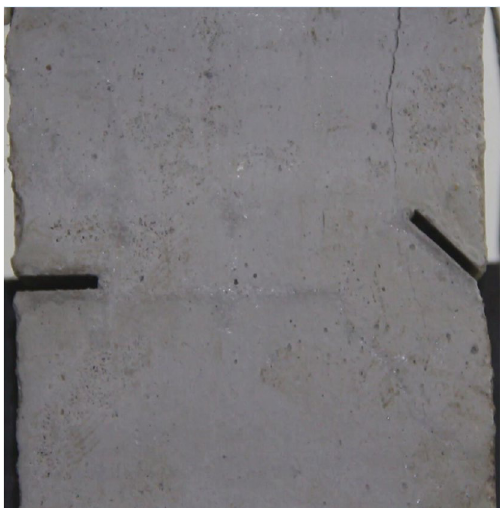
Figure 53. Photograph of a specimen showing tensile crack from the top surface caused by compression appearing.